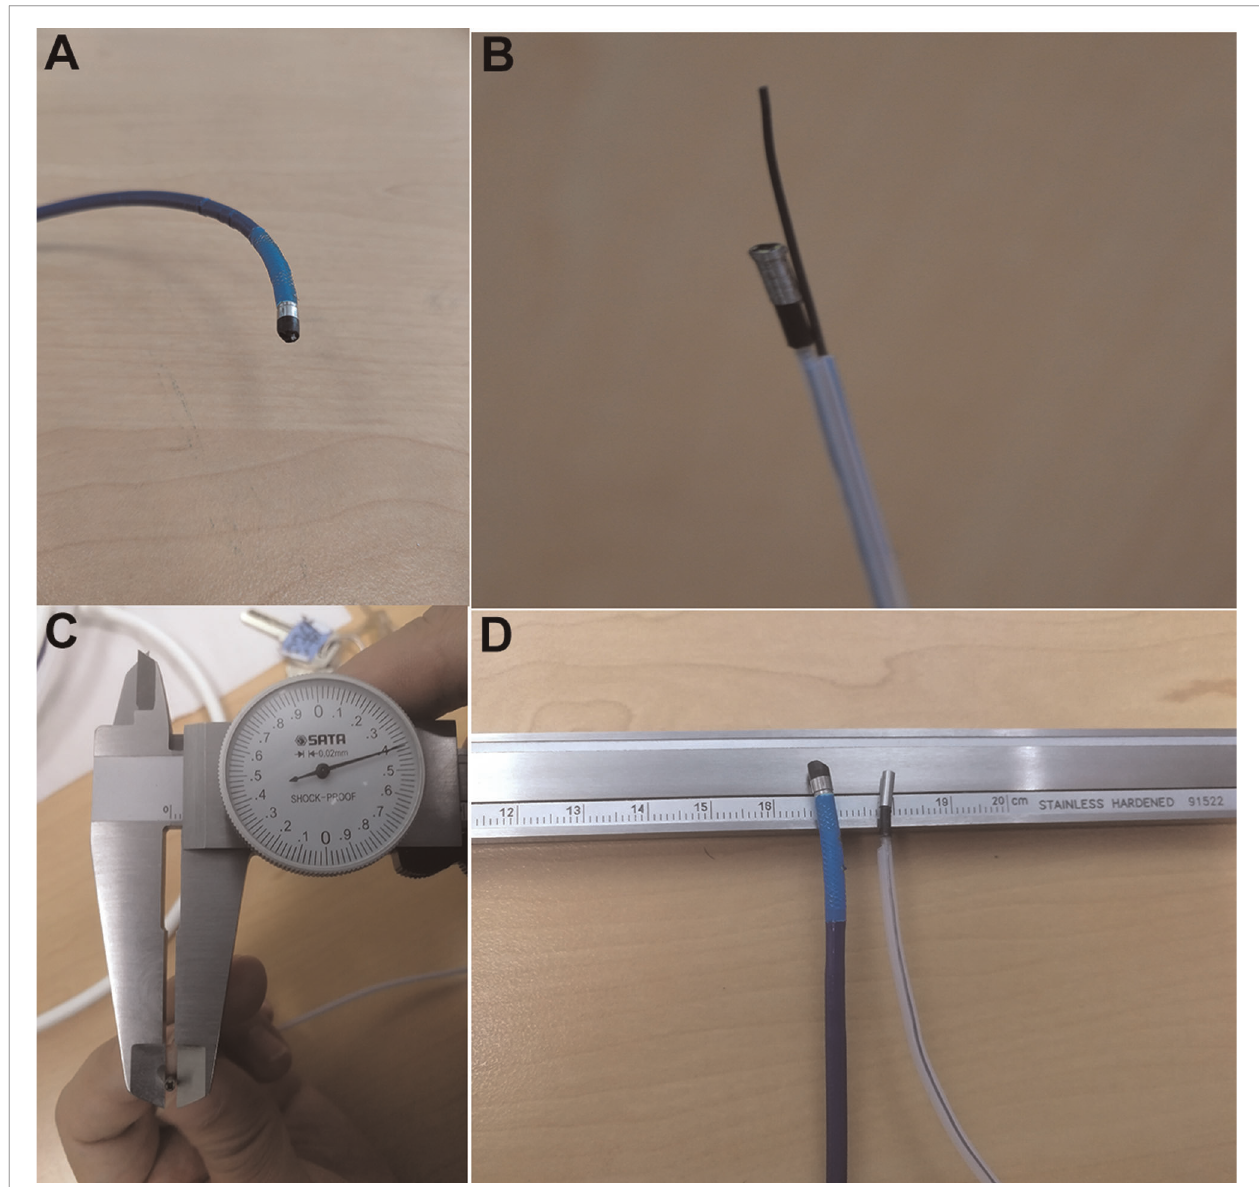
FIGURE 2 | Comparison of front-end diameters. ( A ) Front End of SpyGlass ™ DS, ( B ) Front End of Disposable Super fi ne Catheter for Visual Examination of Bile and Pancreatic Ducts, ( C ) Front-end Diameter of Disposable Super fi ne Catheter for Visual Examination of Bile and Pancreatic Ducts Measured with Micrometer, ( D ) Comparison of Front Ends of the